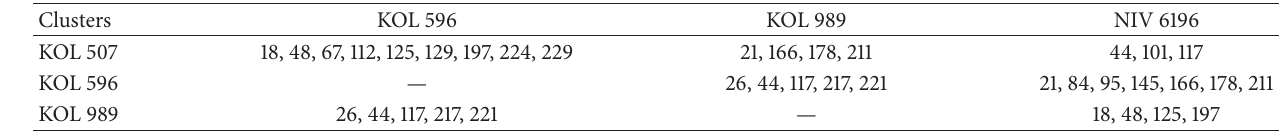
Table 6: Amino acid positions common between clusters.